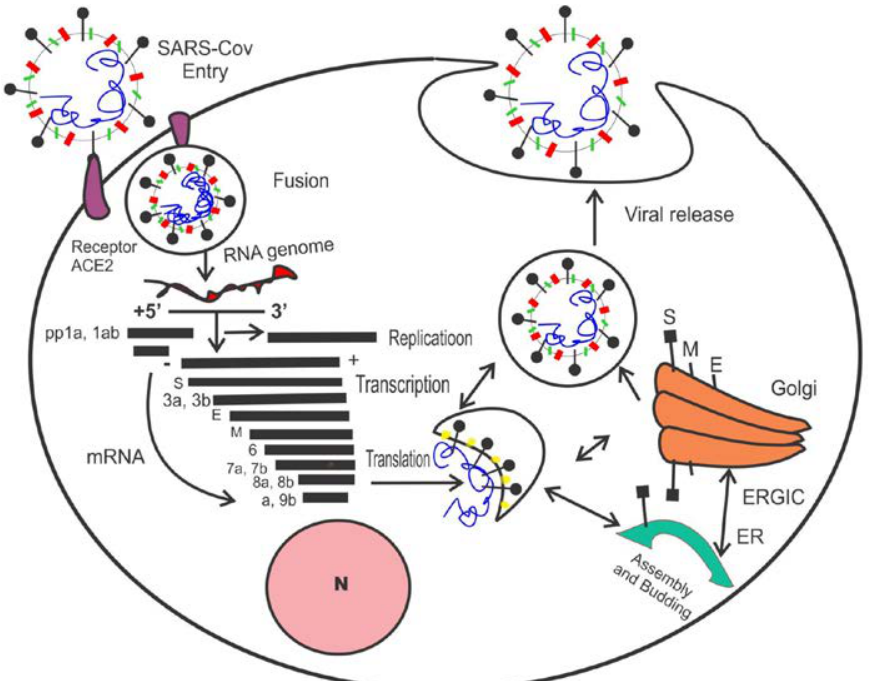
Fig. 2. Life cycle of SARS-CoV in host cells and its S protein structure Image modified from source